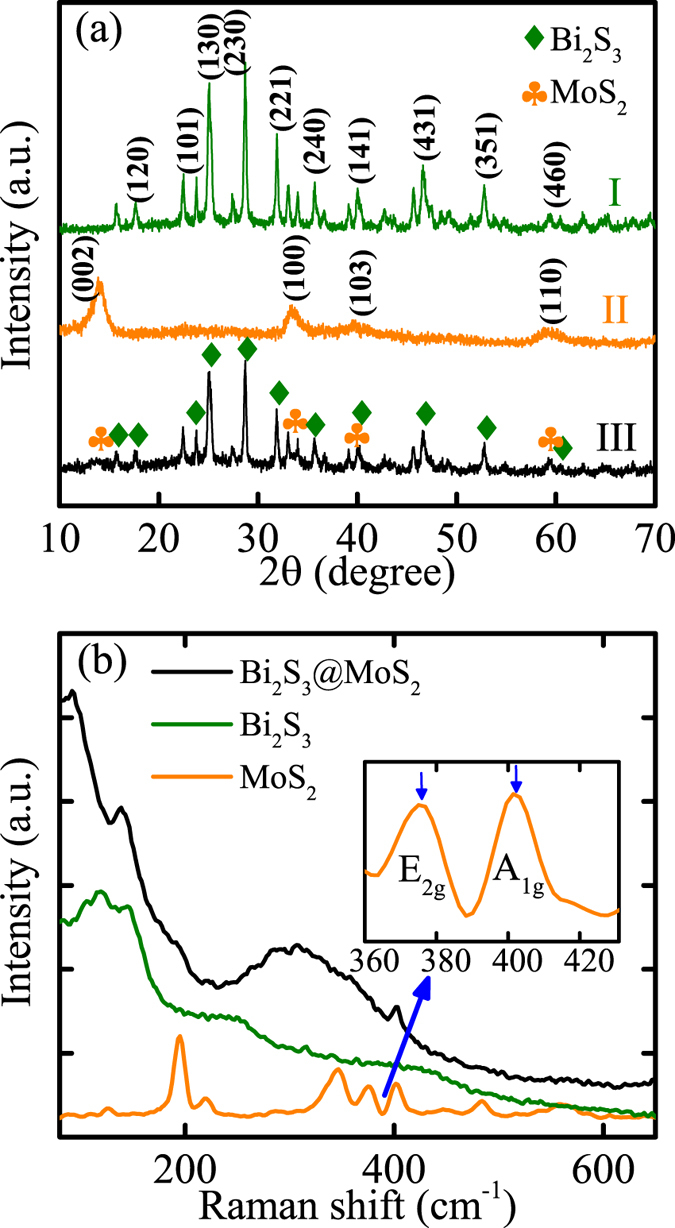
(a) XRD patterns and (b) Raman spectra of pristine of Bi2S3, MoS2, and the D-BM composites. The inset shows both E2g and A1g Raman modes of MoS2.